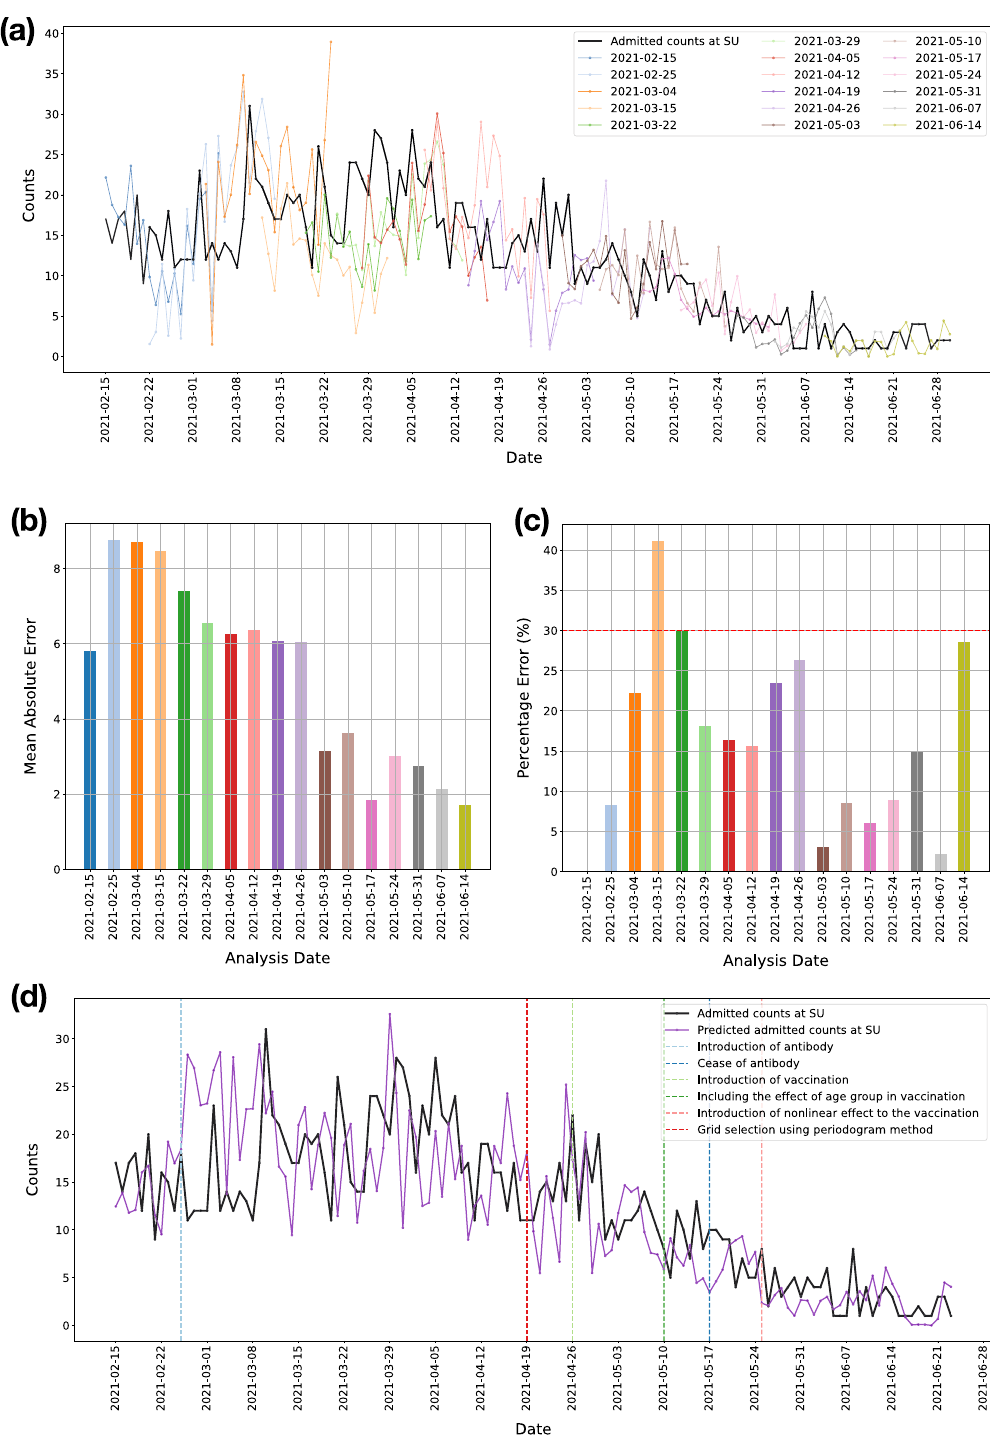
Figure 6. Prediction of the number of admitted COVID-19 patients at Sahlgrenska University Hospital (SU). Forecast models were run regularly for 17 analysis dates (deliverable dates) starting from February 15, 2021 until June 14, 2021. ( a ) Forecasts from the 21-day forecast model at each analysis date. ( b ) Error in prediction in terms of the mean-absolute-error between true and predicted number of admitted patients, averaged across the duration of the forecast window. ( c ) Error in prediction in terms of the percentage error score per analysis date, averaged across the duration of the forecast window. Across all analysis dates, the total number of admitted patients were more than 15 patients. In 16 out of 17 analysis dates, the error is less than 30%. ( d ) Prediction of the number of admitted patients considering forecasts from latest models, built using the latest available data. The evolution of the forecast models is highlighted with markers indicating the major changes to the forecast